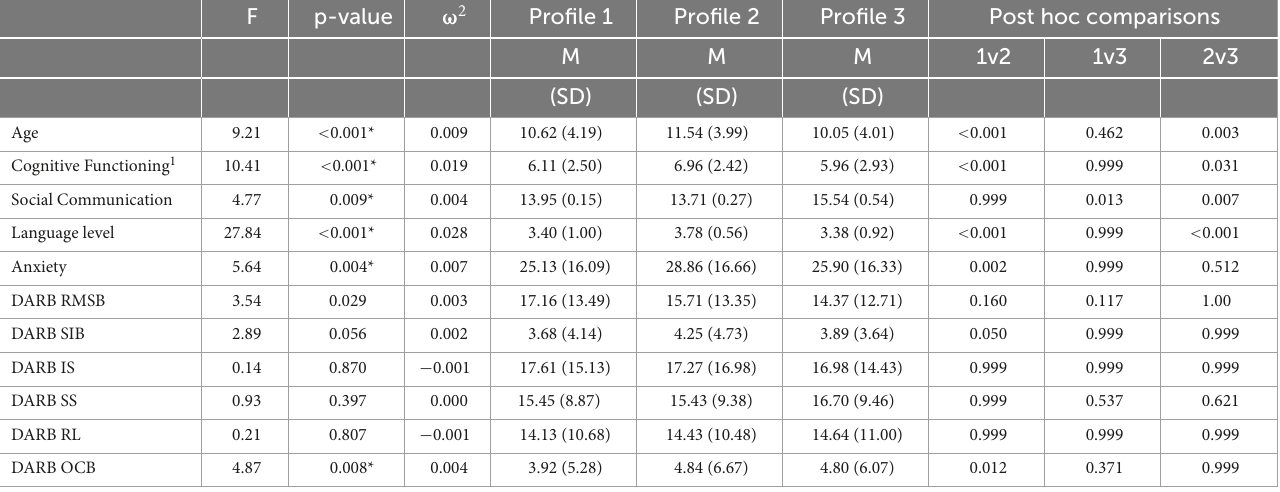
TABLE 4 Profile differences across demographic, cognitive, and clinical characteristics.